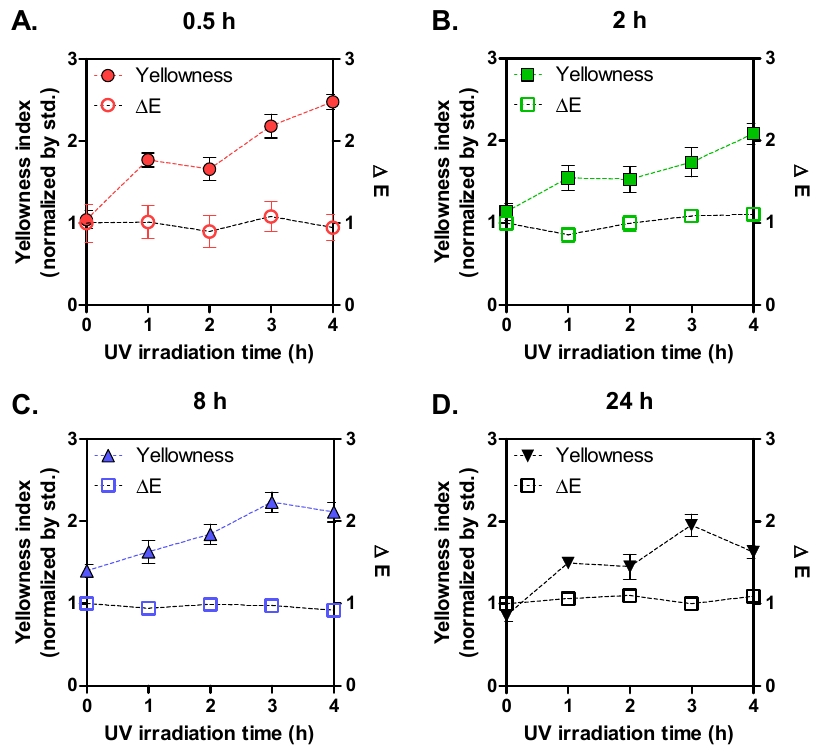
Figure 2. Yellowness and total color differences ( ∆ E) of UV-irradiated SF films (1–4 h) prepared with